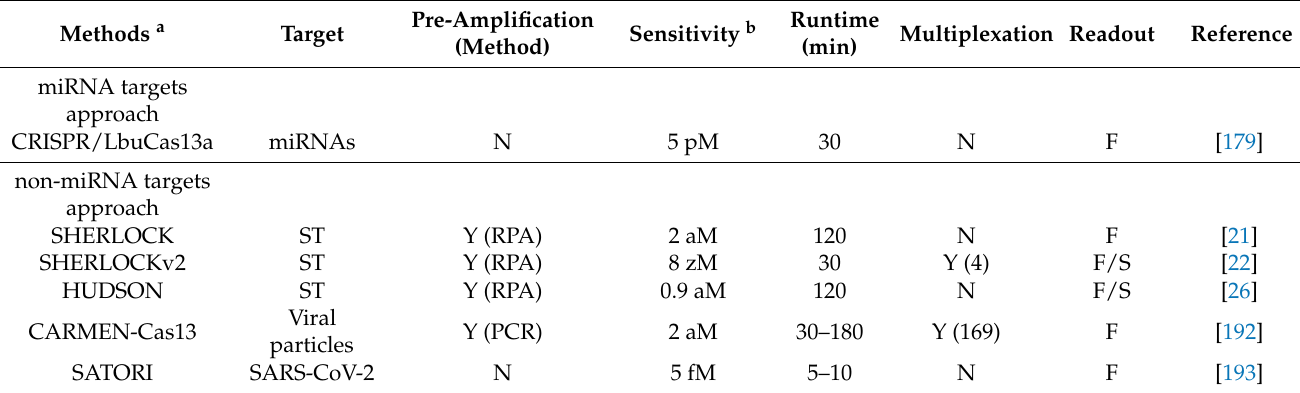
Table 4. Promising molecular CRISPR/Cas13-based platforms for CRC early diagnosis and prognosis showcasing potential applicability and technological